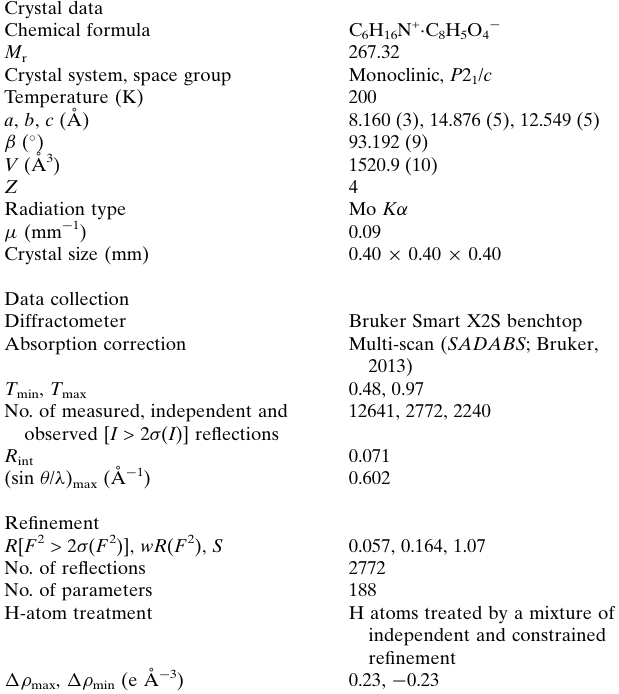
, (cid:3) z + 1 ; ( b ) x + 1, y , z ; ( c ) (cid:3) x + 1, 2 2